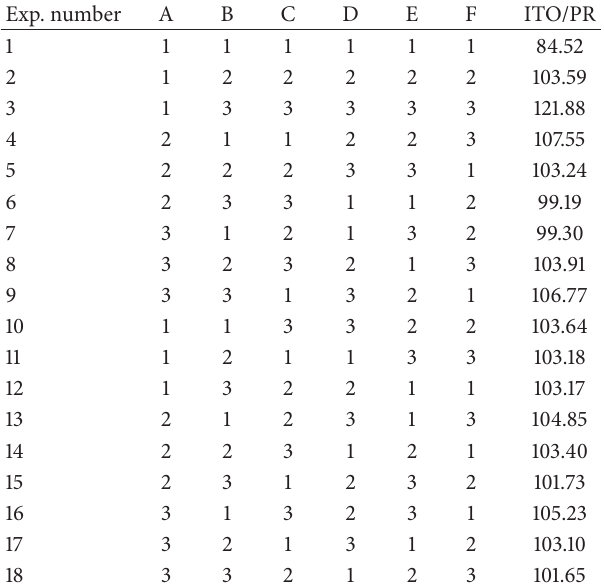
Table 4: 𝐿 18 ( 2 1 × 3 7 ) orthogonal array and the calculated 𝑥 -dir. normal stress of the ITO/PR